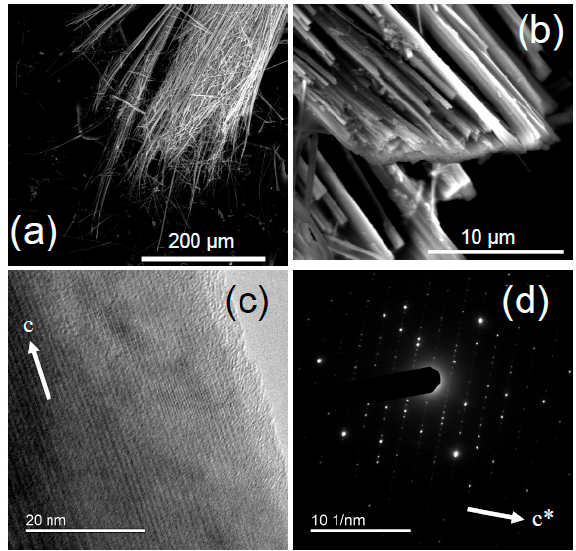
Figure 4. UICC amosite from South Africa NB #4173-111-4 (Table 1). Representative FEG-ESEM images at relatively low ( a ) and high ( b ) magnifications. ( c ) HR-TEM image documenting a limited-extent amorphous cover layer, and ( d ) SAED pattern parallel to the c * axis.